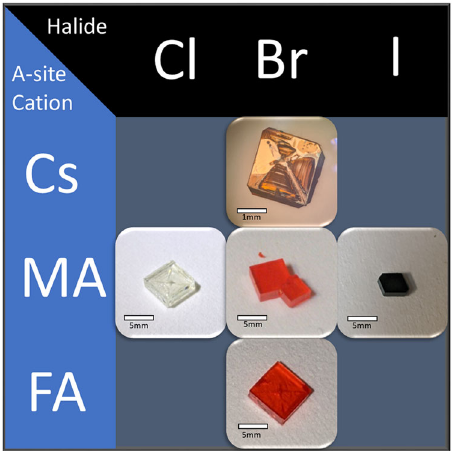
Fig. 1 Pb-based HaP single crystals used in this study. Horizontally: MAPbX 3 (X = Cl, Br, and I); vertically: APbBr 3 (A = Cs, MA,